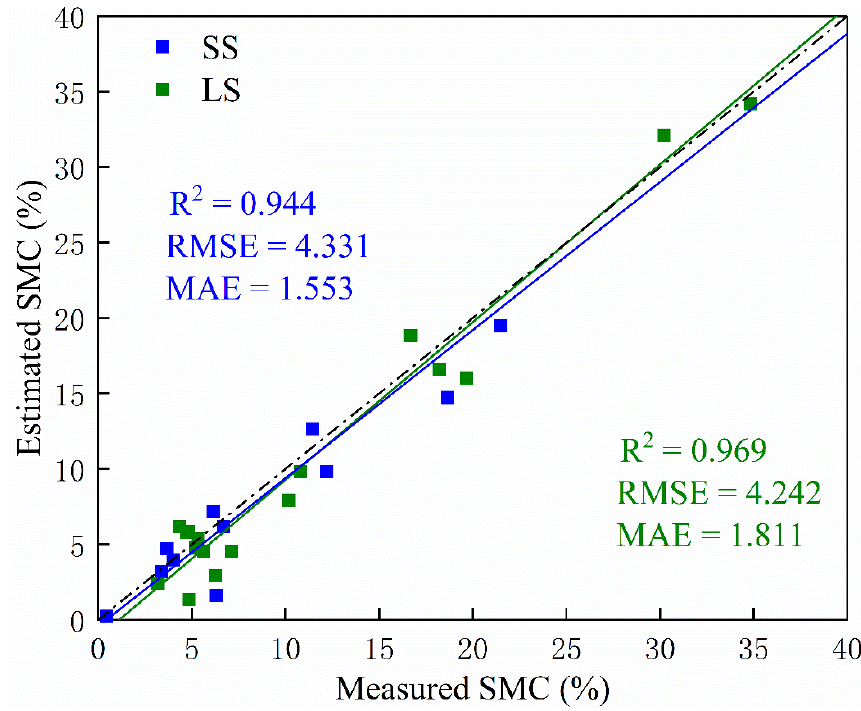
Figure 9. The comparison of measured and estimated SMC of different types of soil.